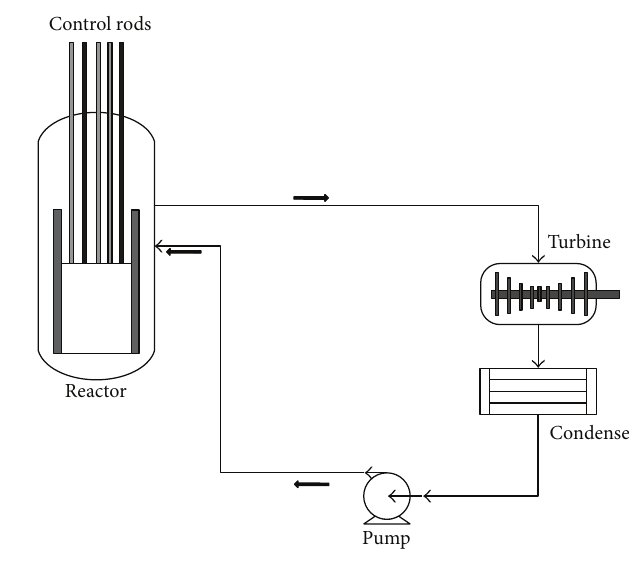
Figure 4: Sketch of SCWR with one